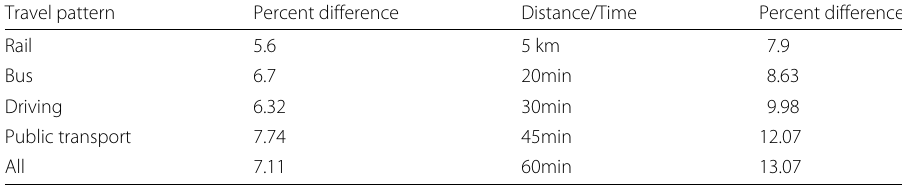
Table 5 The mean percent difference in the correlation matrices across time-radii subnetworks for each network (left) and the mean across travel patterns (right) for each subnetwork Travel pattern Percent difference Distance/Time Percent difference Rail 5.6 5 km 7.9 Bus 6.7 20min 8.63 Driving 6.32 30min 9.98 Public transport 7.74 45min 12.07 All 7.11 60min